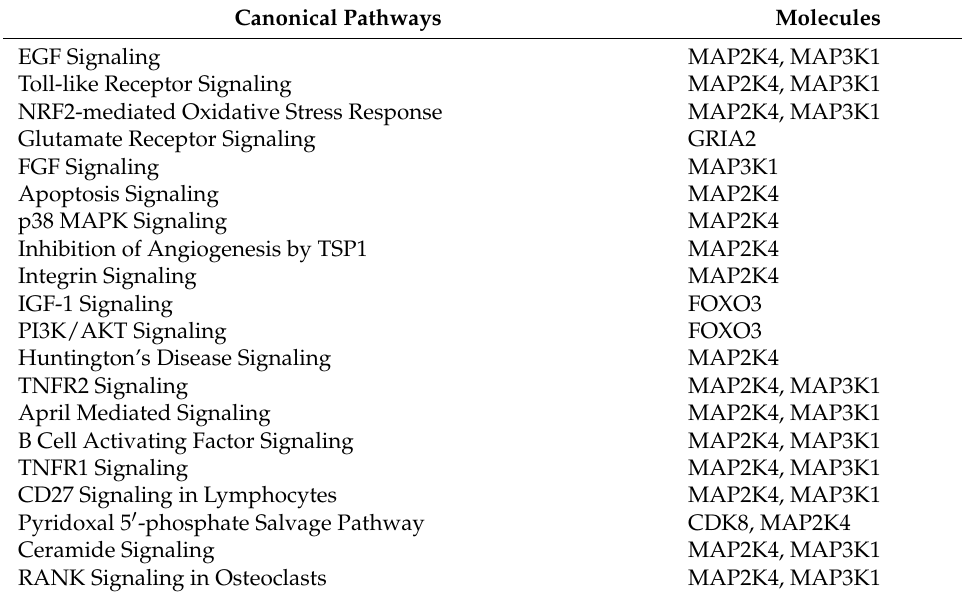
Table 5. Canonical pathways associated with top 20 hsa-miR-21-3p target genes. Canonical